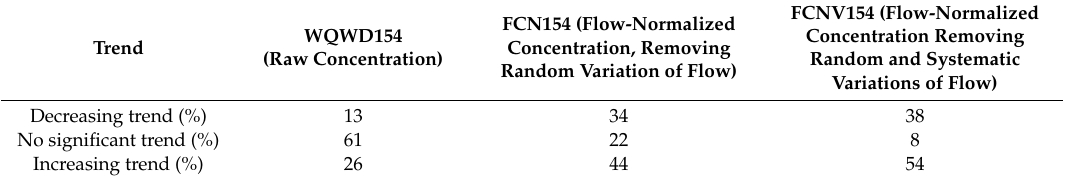
Table 8. Trend analysis of annual nitrate concentration using raw and flow-normalized concentrations using the Mann–Kendall trend test for the period 1990–2017 after removal of random and systematic variation due to flow variability. FCNV154 (Flow-Normalized FCN154 (Flow-Normalized WQWD154 Concentration Removing Trend Concentration, Removing (Raw Concentration) Random and Systematic Random Variation of Flow) Variations of Flow) Decreasing trend (%) 13 34 38 No significant trend (%) 61 22 8 Increasing trend (%) 26 44